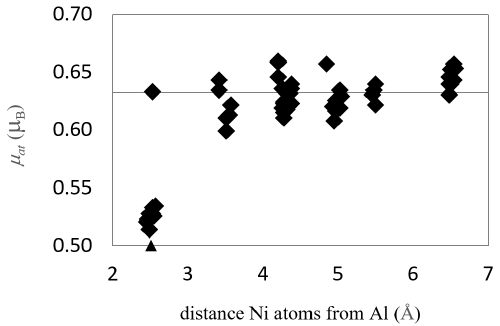
Figure 2. The dependence of the magnetic moment of Ni atom on its distance from Al (s) in the structure Ni 58 Al (s) + Va (the vacancy is situated in the first nearest neighbor position of the Al atom ( D = 2.4594 Å)). The line corresponds to the calculated value of magnetic moment of bulk fcc Ni 0.632 μ B .